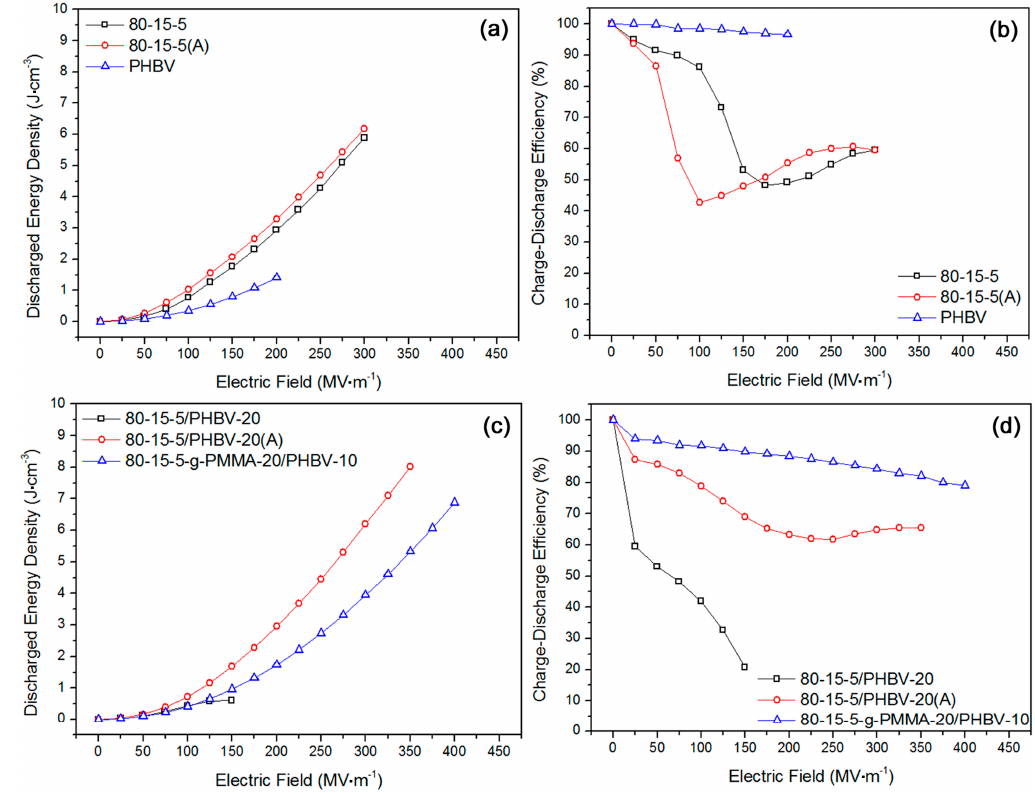
Figure 6. No significant elevation of energy storage properties after the annealing was verified for ( a , b ) 80-15-5 sample, and notable improvement of energy storage performances after annealing was confirmed for ( c , d ) 80-15-5/PHBV-20 sample.